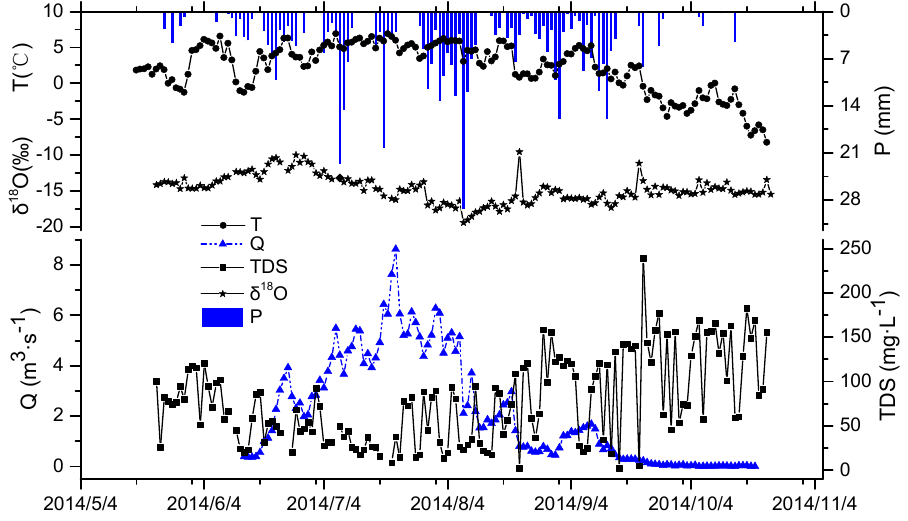
Figure 2. Daily values of the TDS, δ 18 O values, precipitation (P), temperature (T), and discharge (Q) in the summer season (glacier ablation period) of 2014 in the Dongkemadi River Basin.